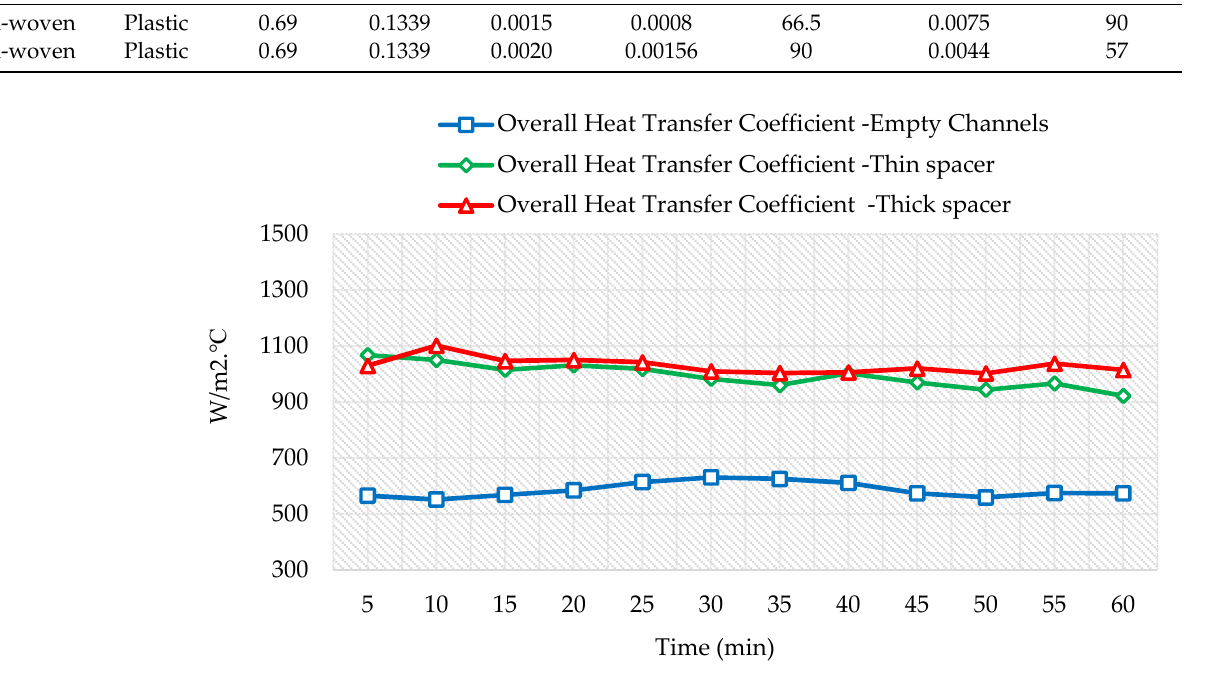
Figure 13. Heat transfer in the empty and spacer-filled channels by using 3 L/min.